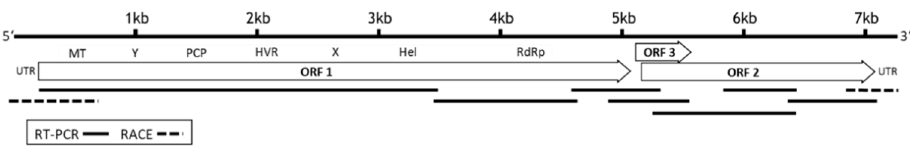
Figure 1. Genome organization and schematic representation of the amplicons used for dideoxy- chain termination (Sanger) sequencing of the complete HEV genome. The genome was determined by sequencing of seven overlapping fragments (solid line), generated by RT-PCR and rapid amplification of cDNA ends (RACE, dotted line). The open reading frame 1 (ORF1) codes for methyltransferase (MT), Y-domain (Y), papain-like cysteine protease (PCP), hypervariable region (HVR), X-domain, RNA helicase (Hel), RNA-dependent RNA polymerase (RdRp), ORF2 codes for capsid protein, and ORF3 for a small accessory protein. Untranslated regions (UTR) are located at the 5’ and 3´ends of the genome.